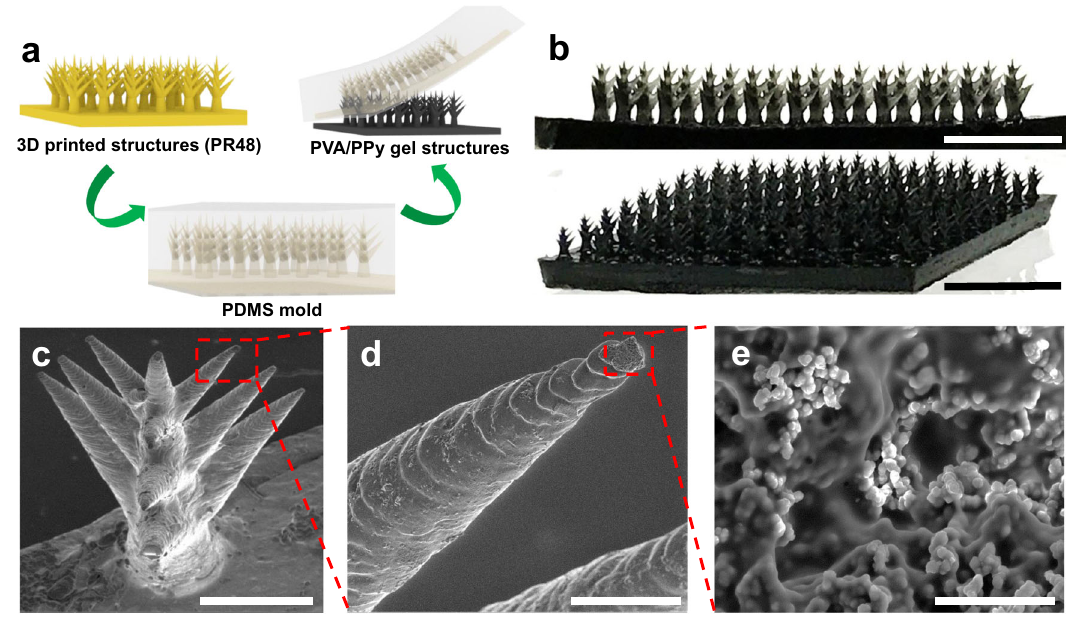
Fig. 2 Fabrication and structure characterization of microstructured PVA/PPy gel membranes. a Schematic illustration of the fabrication of microstructured PVA/PPy gel membranes. b Images of representative fabricated PVA/PPy gel micro-tree array. Scale bar: 1 cm. c Images of an individual representative tree micro-topology. Scale bar: 1 mm. d SEM image of one gel branch. Scale bar: 50 µ m. e Porous structure of gel matrix. Scale bar: 5 µ